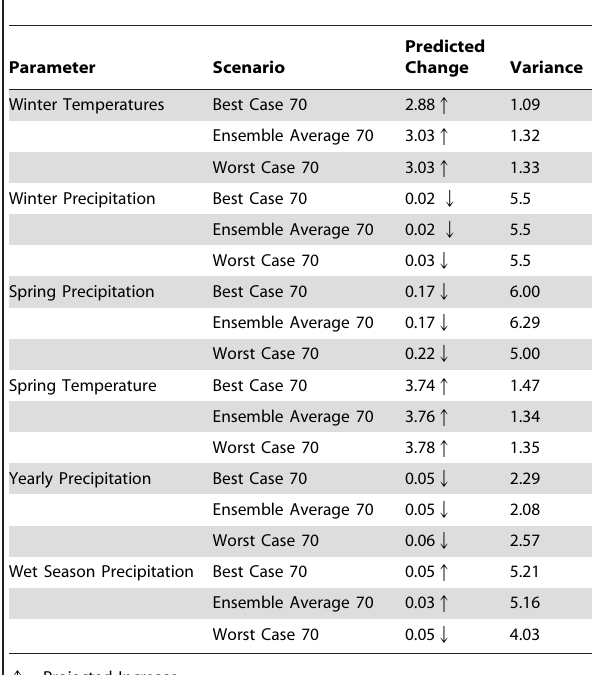
Table 3. Mean predicted change for temperature ( u C) and precipitation (cm) from 3 climatic forecasts used to predict mean clutch size, incubation initiation, and daily nest survival for lesser prairie-chicken populations in